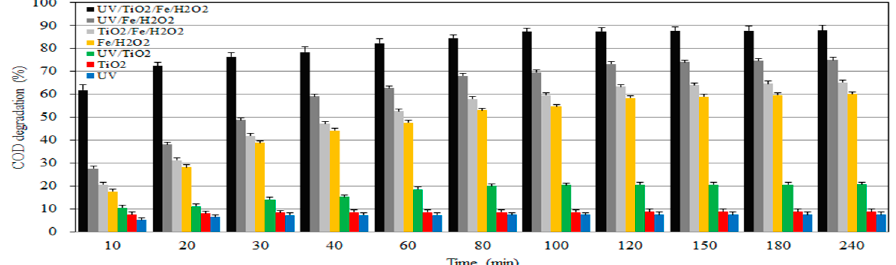
ff erent treatment